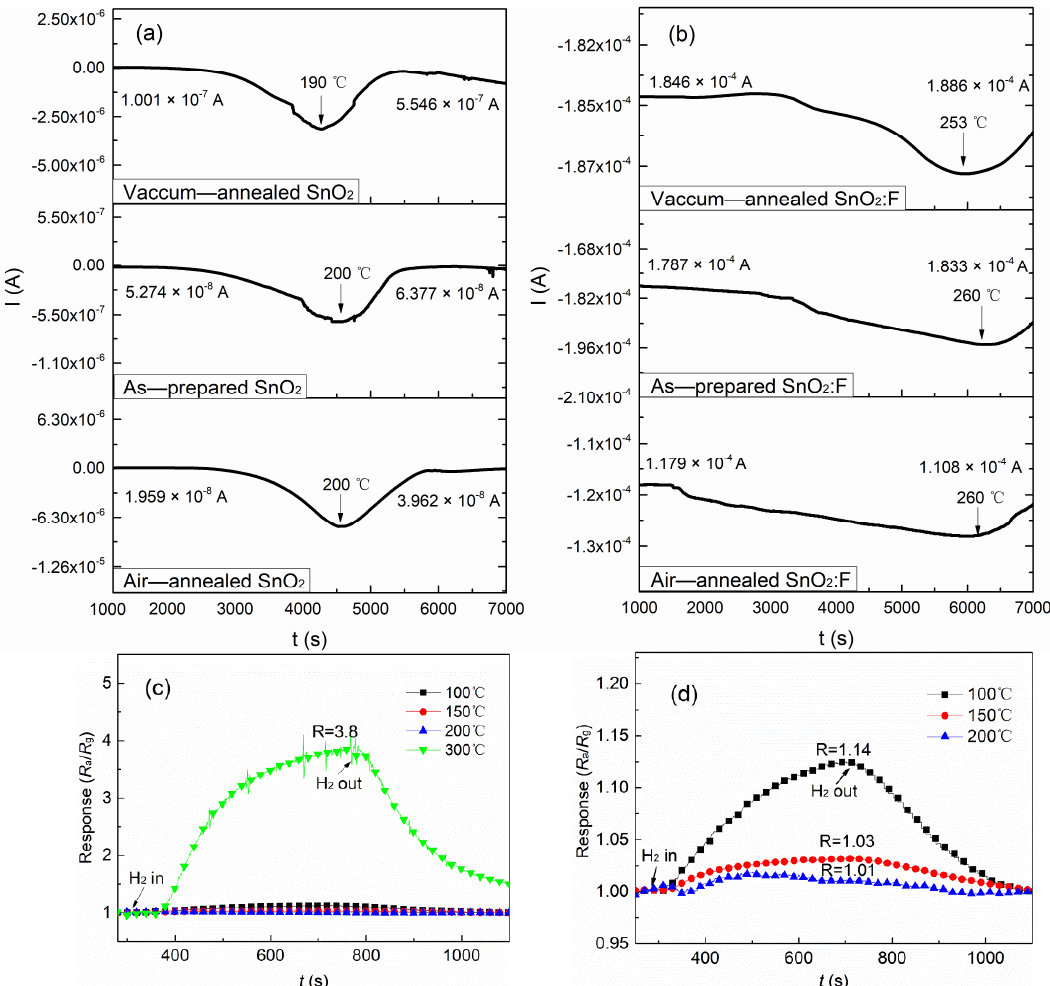
Figure 4. The current – temperature curves of ( a ) as-prepared and annealed SnO 2 films, ( b ) as-prepared and annealed SnO 2 :F films, and ( c ) H 2 response of as-prepared SnO 2 films at different temperatures, ( d ) magnified view at 100 – 200 °C in ( c ).